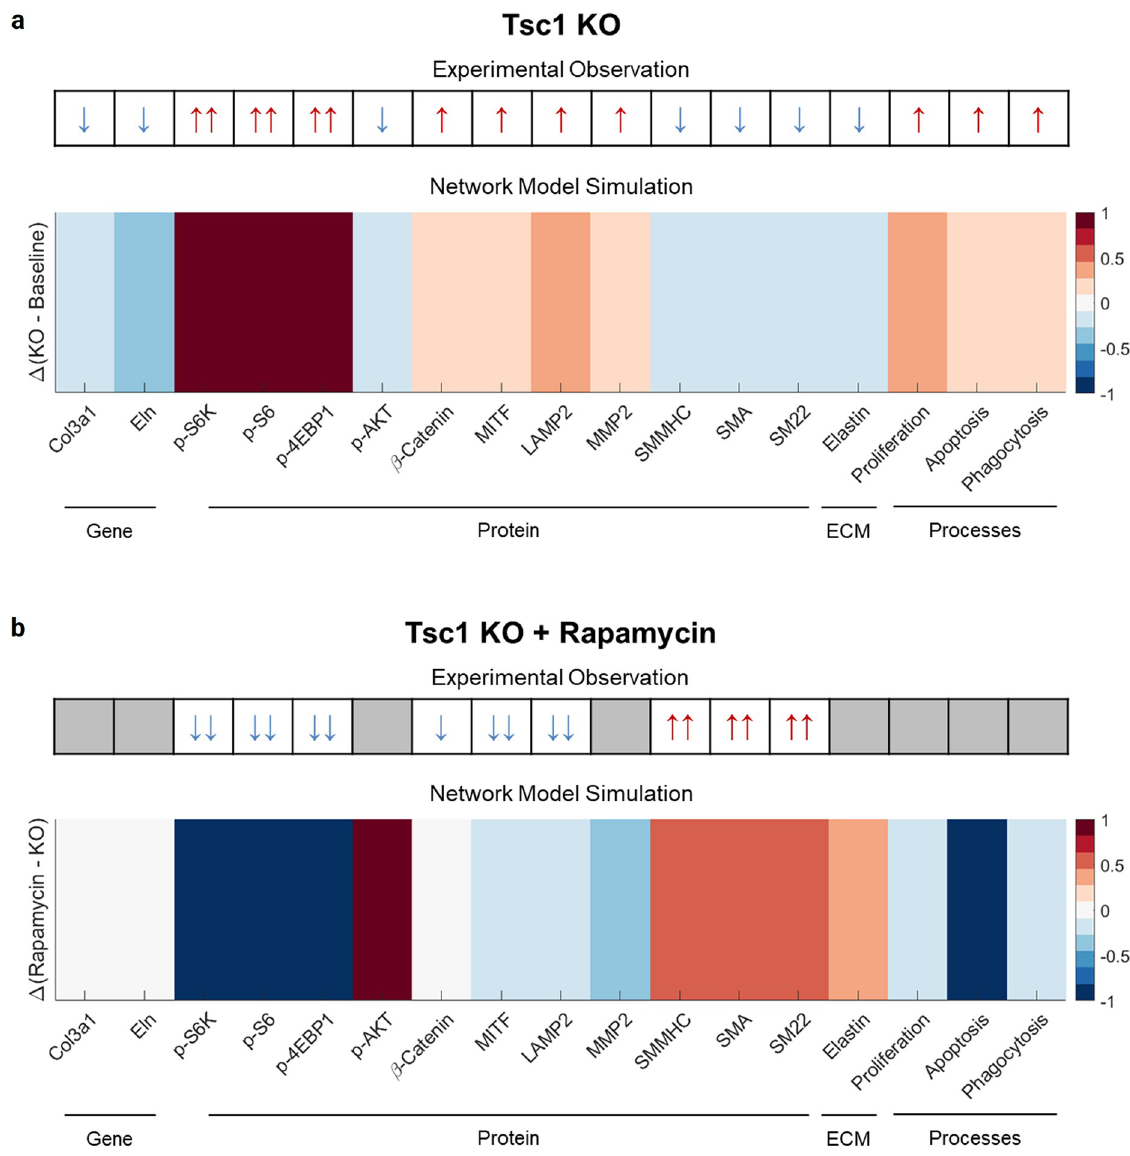
Fig 2. Qualitative comparison between network model simulations and experimental data reported by Li et al. [10]. a) Conditional Tsc1 knock-out (KO) in aortic smooth muscle cells led to significant experimentally measured changes in various species at gene and protein (intracellular and extracellular matrix) levels, as well as increases in cell proliferation, apoptosis, and degradative activity. The signaling network model qualitatively captured all of these experimental changes between the KO and baseline cells. b) Addition of the mTORC1 inhibitor rapamycin to the KO cells led to decreases in mTORC1-associated species and lysosome-related species, as well as an increase in contractile protein expression. The signaling network model also qualitatively captured these experimental observations for rapamycin administration in the KO mice. See also S2